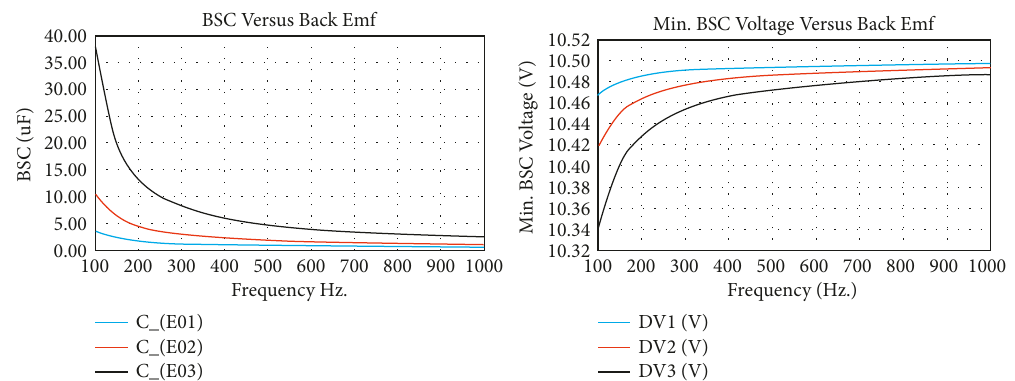
Figure 10: Variation of the BSC and minimum voltage with frequency at different back